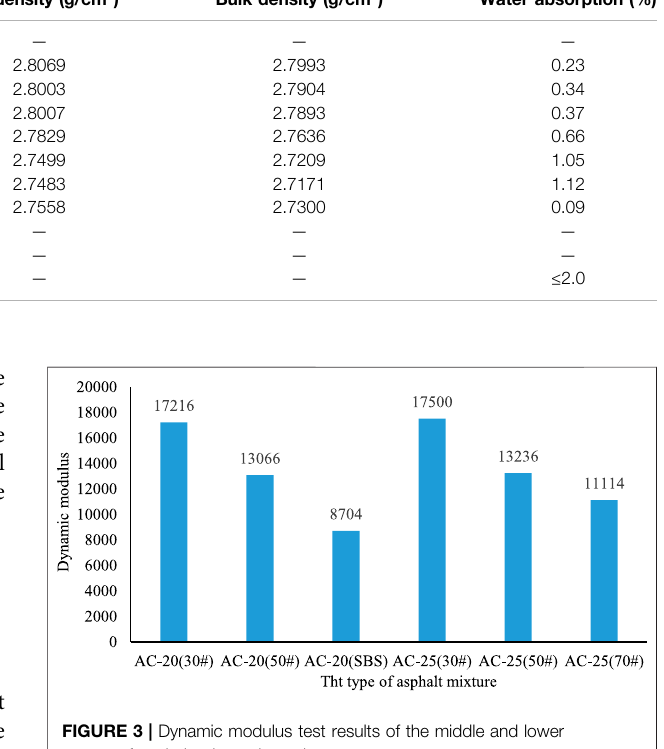
TABLE 3 | Main technical performance test of aggregate. Particle size (mm)